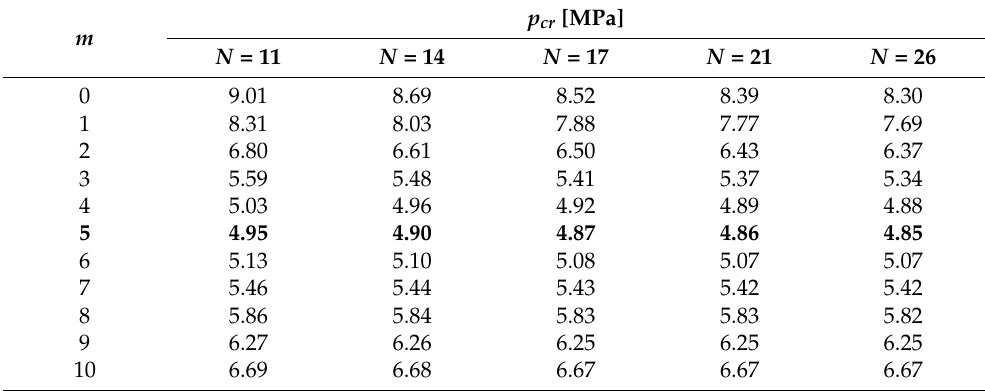
Table 1. Critical static load p cr of the composite plate model with Poisson’s ratio ν = − 0.6 for auxetic facings radially compressed on the outer edge versus different numbers of discrete points N .